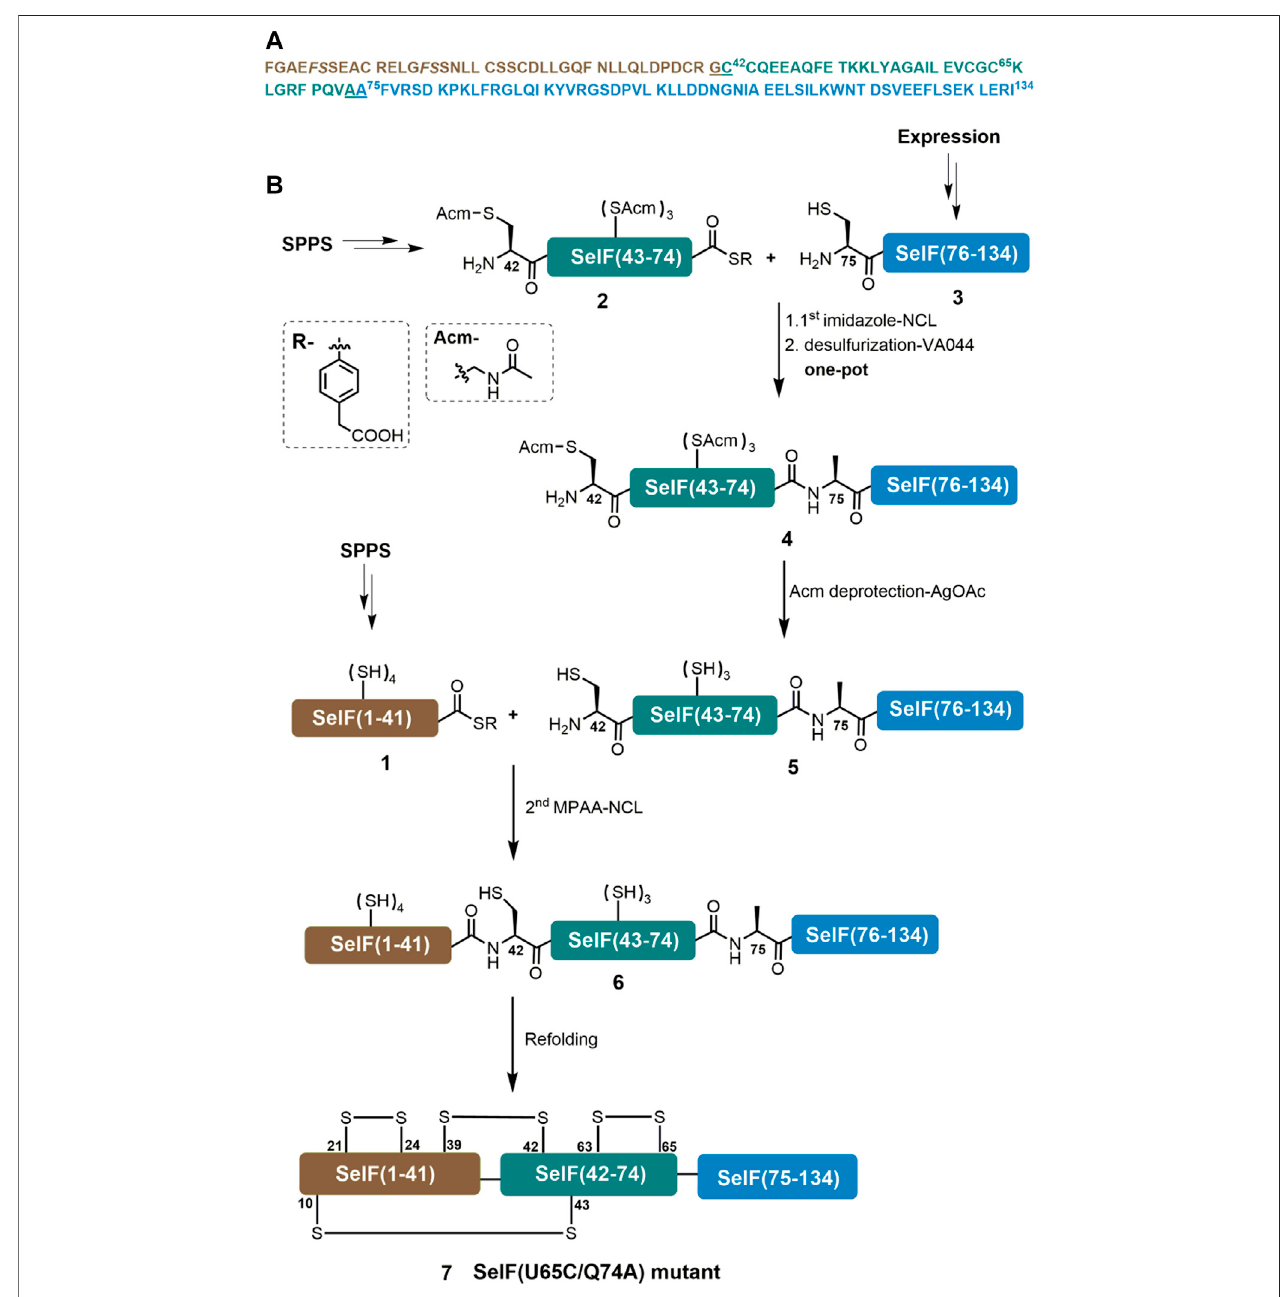
FIGURE 1 | Chemical synthesis of SelF(U65C/Q74A). (A) Sequence of the mature form of SelF(U65C/Q74A). The ligation sites are underlined, and the pseudo- proline dipeptide building blocks used during SPPS are shown in italic. (B) Synthetic strategy used in the current work.